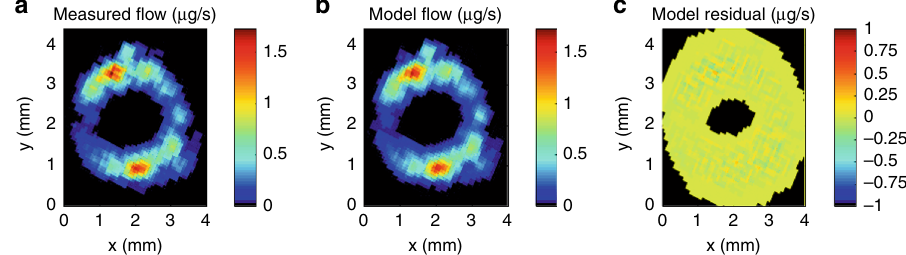
Fig. 5 Independent pressures scenario. a Observed fl ow rates ( µ g s − 1 , colour scale) averaged in 5-by-5 pixel window. b Model predicted fl ow rates ( µ g s − 1 , colour scale) with separate pressure value set for each vessel group ( n = 317) at top of domain, downsampled to 78 µ m resolution and averaged over 5-by-5 pixel window. c Residuals between model and observed ( µ g s − 1 , colour scale).